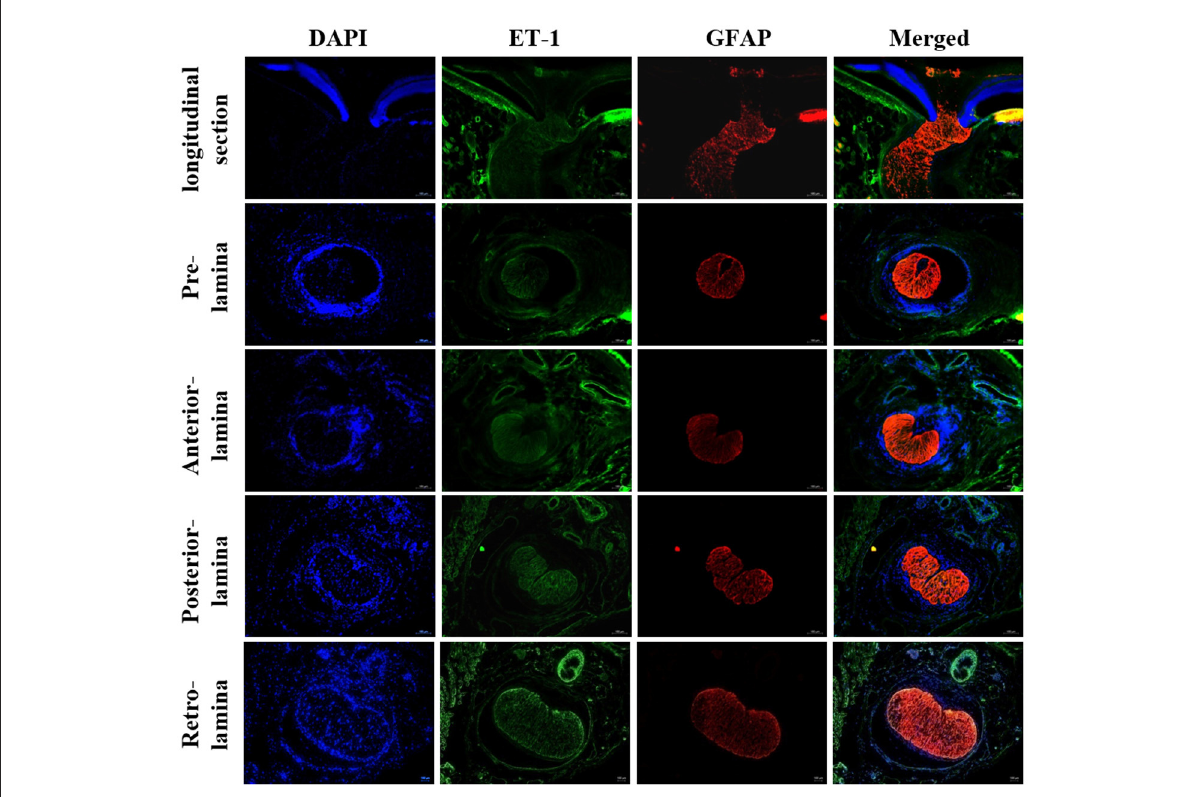
FIGURE2 Immunofluorescent staining for ET-1 in rat LC tissues. Staining for ET-1 was mainly located in the surface layer of ONH, LC, retrobulbar optic nerve, and central retinal vessels. ONH, Optic nerve head; LC, Lamina cribrosa; ET-1, Endothelin